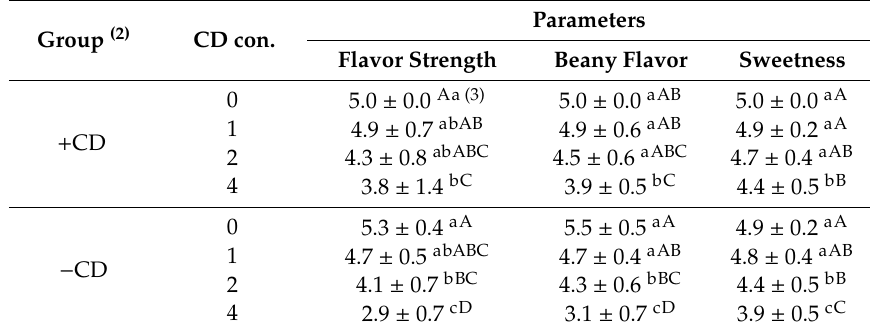
Table 2. Sensory evaluation of flavor strength, beany flavor, and sweetness in ISP colloids depending on the CD concentrations and centrifugation process